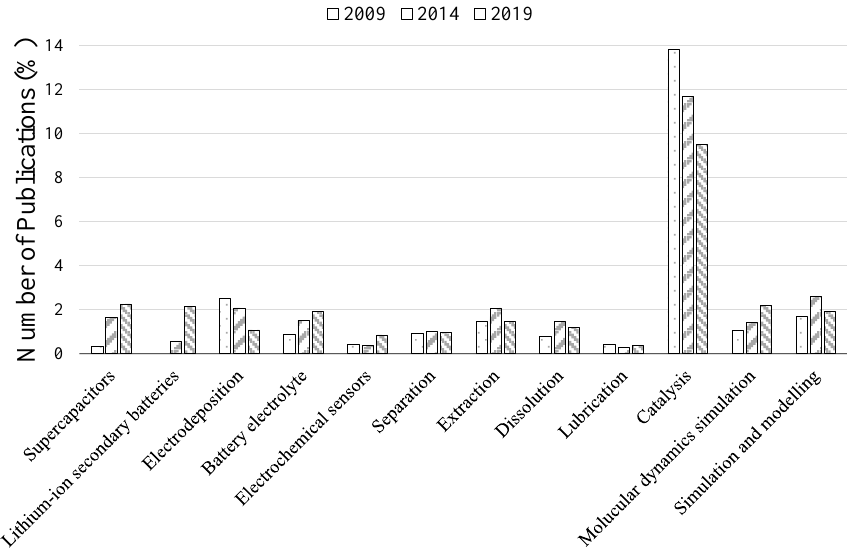
Figure 6. The number of ionic liquid publications in 2009, 2014 and 2019, over a selection of topics found using the “Categorize” function in SciFinder TM . The data have been normalised by the total number of publications in that particular year.